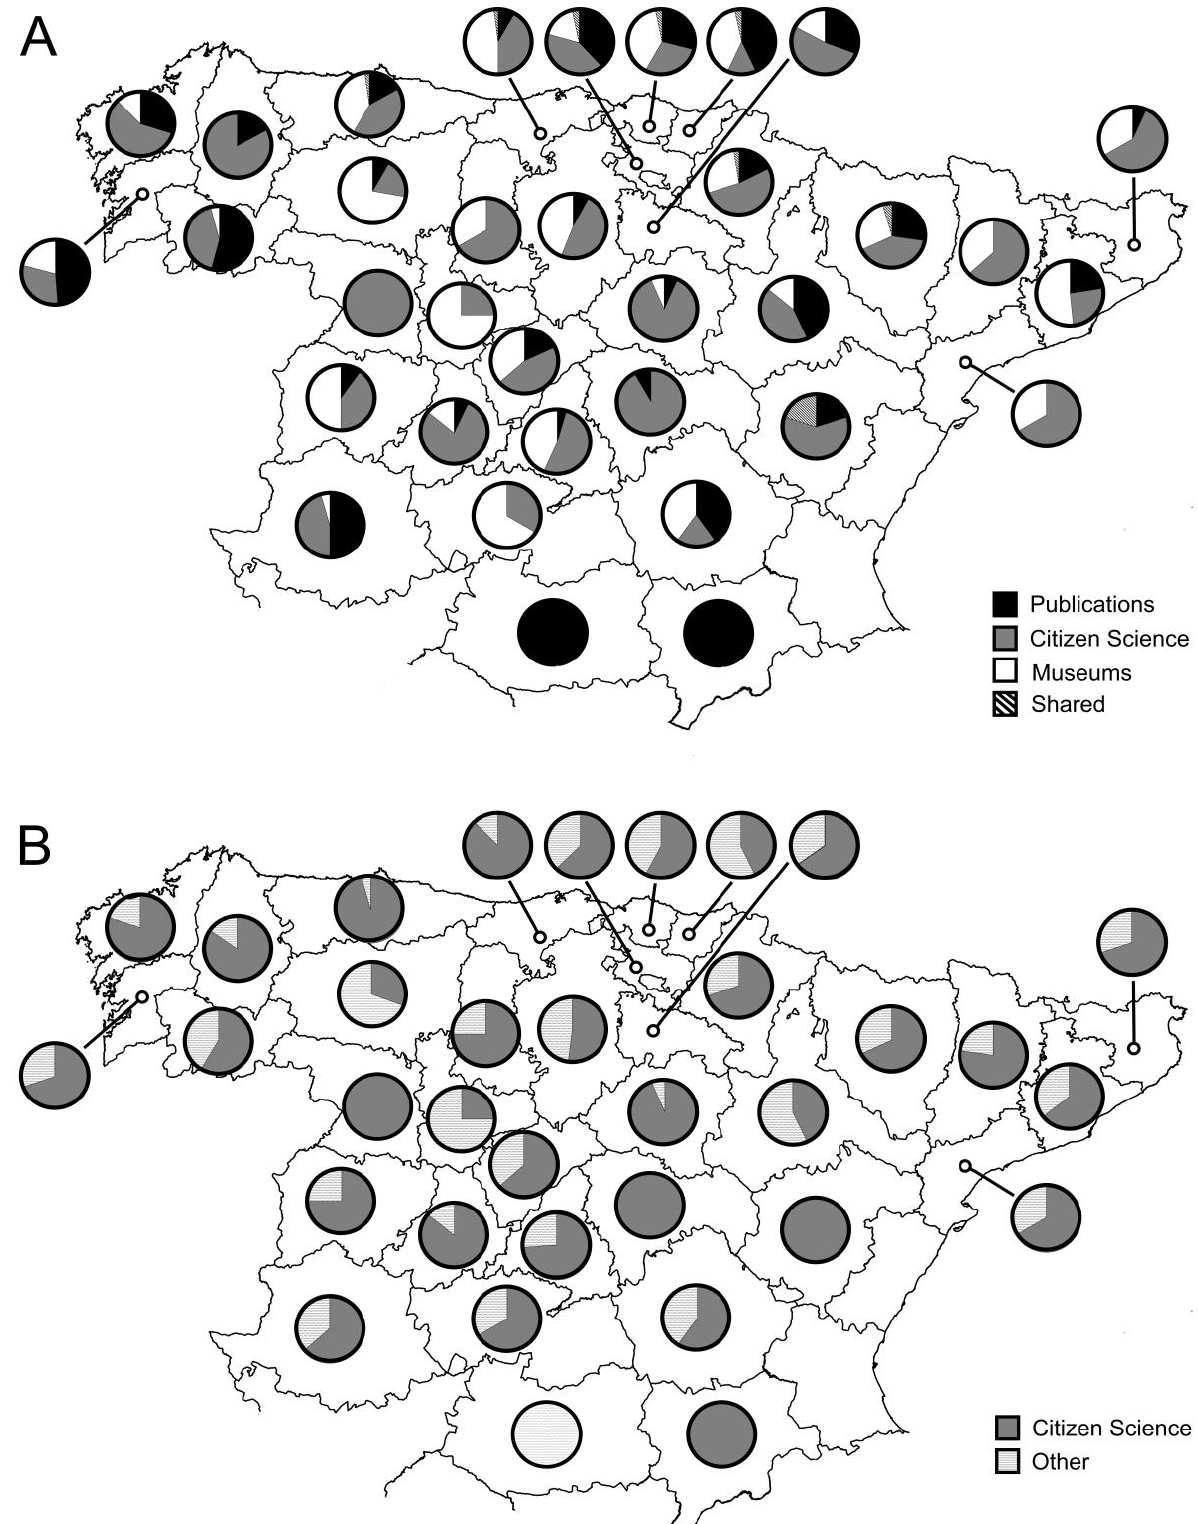
Figure 3. ( A ). Relative contribution by each data source to the number of grid cells known per province. ( B ). Relative number of grid cells contributed by citizen science, including those shared with other data sources, and grid cells uniquely contributed by other data sources.